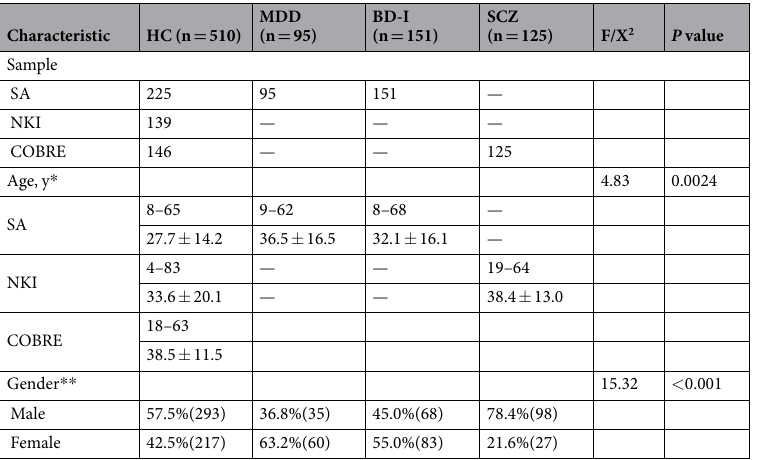
Table 1. Demographic information of all subjects. * Mean and standard deviation, p value according to ANOVA; ** Relative (%) and absolute (n) frequencies; p value according to χ 2 test; Abbreviations: BD-I, Bipolar 1 Disorder; COBRE, Center of Biomedical Research Excellence; HC, Healthy Control; MDD, Major Depressive Disorder; NKI, Nathan Kline Institute; SA, San Antonio; SCZ,